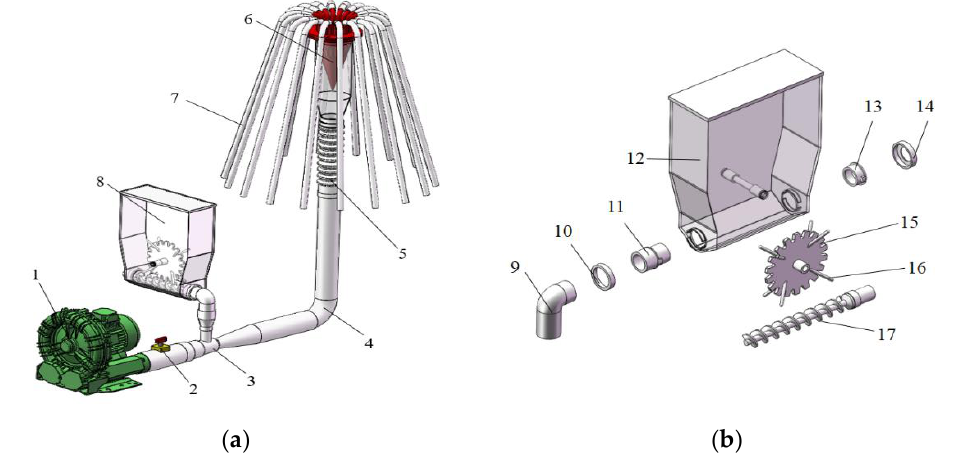
Figure 1. Alfalfa Pneumatic Collector: (a)General Assembly Diagram,and (b) Disassembly Diagram